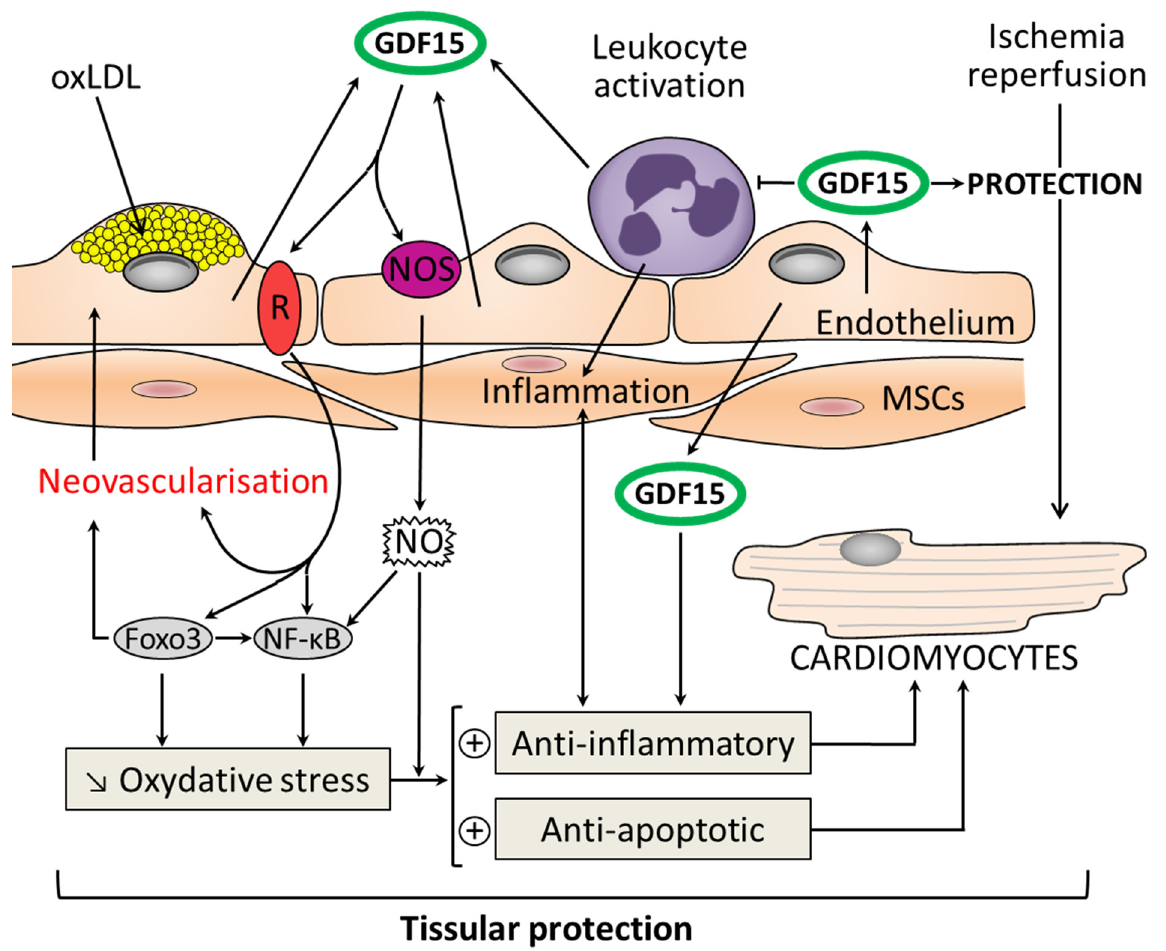
Figure 3. Molecular pathways for the action of GDF15 in myocardial protection as a result of its antioxidant, anti-inflammatory, and antiapoptotic properties. GDF15 has a local cardioprotective role due to its autocrine/paracrine functions. GDF15 expression is highly induced in cardiomyocytes after ischemia/reperfusion. GDF15 is an inhibitor of leukocyte activation and recruitment by direct interference with chemokine signaling and integrin activation. GDF15 activates nitric oxide: NOS/NO/nuclear factor κ B (NF κ B) pathway and among the forkhead box (FOX) transcription factors: Foxo3. This induces an antioxidant action and promotes neovascularization. The development of atherosclerotic plaques is driven by endothelial dysfunction, oxidized low-density lipoprotein (oxLDL) in association with recruitment of monocytes. GDF15 is highly expressed in plaques. GDF15 protects the vessel against injury and oxidative stress thanks to its anti-inflammatory and antiapoptotic properties (+: activation; : decrease)..